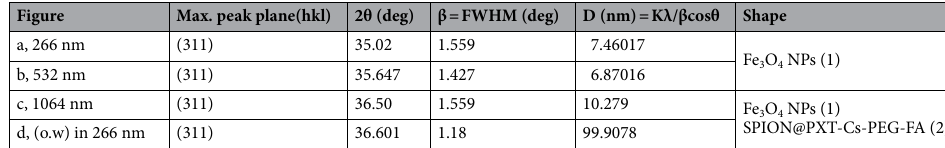
Table 5. Variations in max. plane (311) maximum FWHM, D, and lattice parameters of Fe 3 O 4 NPs after ablation with an Nd:YAG laser at different laser wavelengths and fluence of 28 J/cm –2 in KMnO 4 solution.